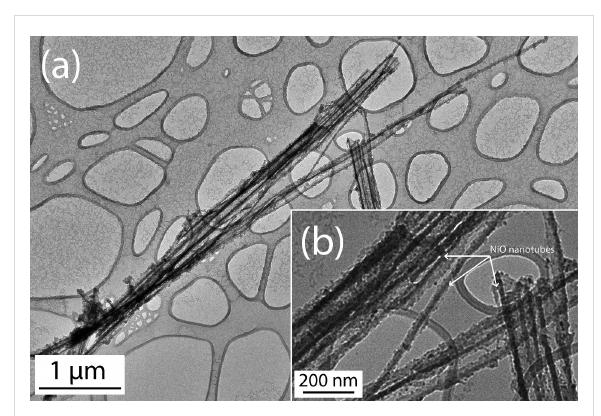
Figure 4: (a) TEM image of NiO nanotubes after alumina template removal. (b) Enlarged view of NiO nanotubes.